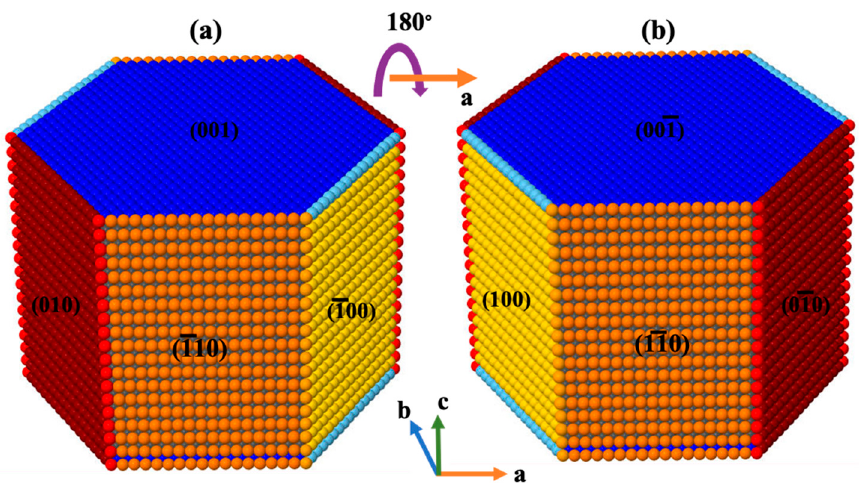
Figure 4. Snapshots of the crystal morphology of portlandite consisting of 17,461 sites from two various perspectives (dimensions of lateral rectangle are 6.094 nm × 8.768 nm). For better visualization of each facet, they were shown with different colors, while atoms with less neighbors have lighter color tone. Figure on the right side ( b ) represents a 180-degree rotation about ( a ) axis of the crystal on the left side.